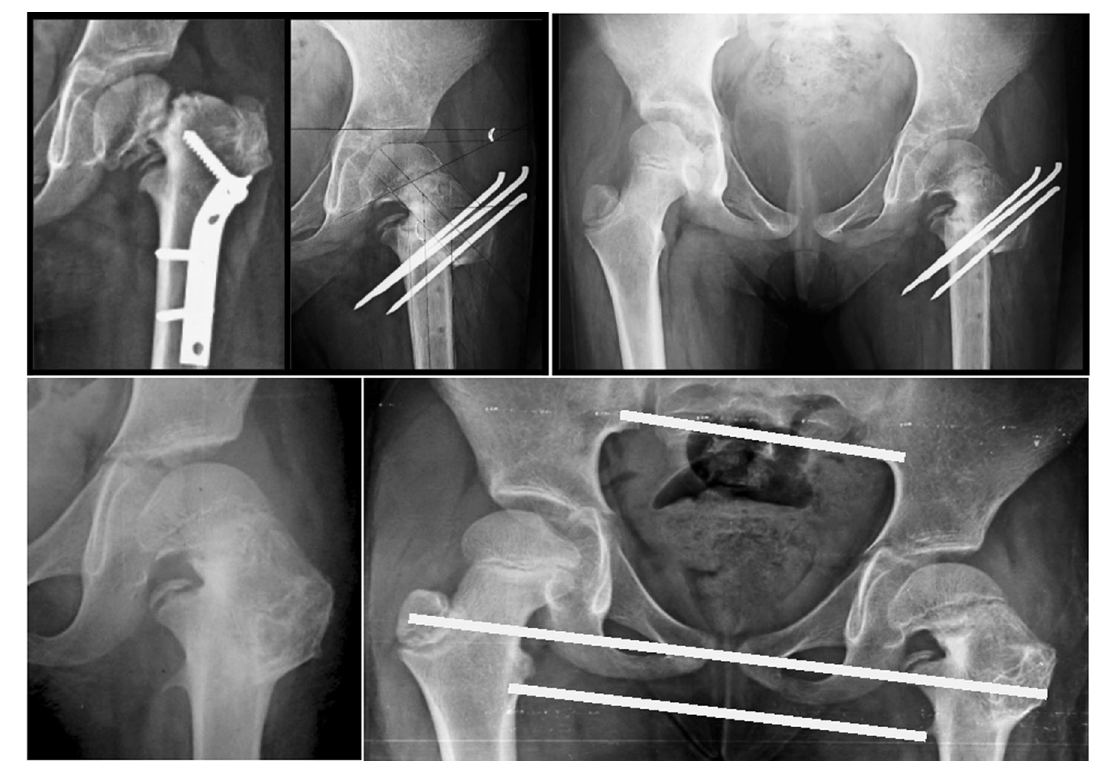
Fig. 6 Revision osteotomy for residual coxa vara after a previous osteotomy that involved fixation with a plate. Revision osteotomy led to near-normal HEA and FNSA. The osteotomy healed completely,